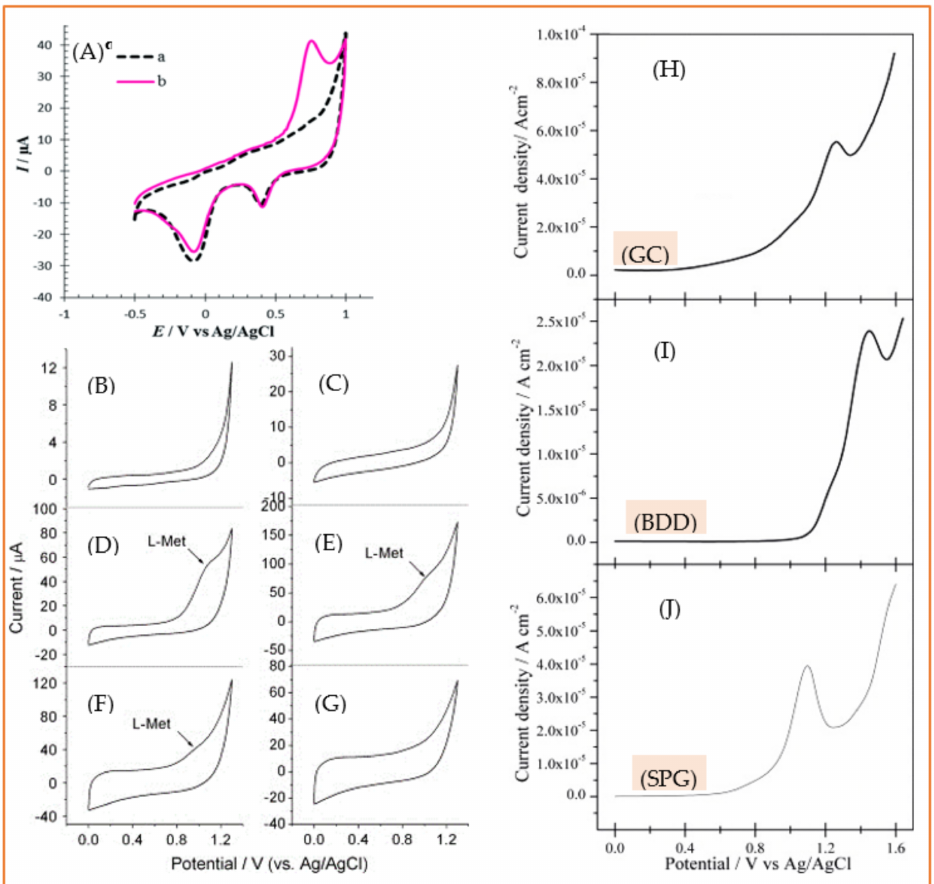
Figure 8. ( A ) Cyclic voltammograms of Ru/Pt-modified electrode ( A ) without and ( B ) with 100 µ M methionine in 0.1 M phosphate buffer solution (pH = 7), with a scan rate 10 mV s − 1 . Reprinted with permission from ref. [184]. Copyright 2017 Royal Society of Chemistry. CVs of 5 mM methionine in pH 5.5 PBS at bare GC ( B ) and GO/GC electrodes pretreated at different potentials. ( C ): − 0.65 V; ( D ): − 0.75 V; ( E ): − 0.8 V; ( F ): − 0.9 V; ( G ): − 1.2 V, Reprinted with permission from ref. [195]. Copyright 2011 Elsevier. Comparison of the DPV of different carbon-based electrodes: GC ( H ), BDD ( I ) and SPG ( J ) electrodes for the direct oxidation of 1 mM methionine in 0.1 M phosphate buffer solution (pH 7). Reprinted with permission from ref. [196]. Copyright 2014